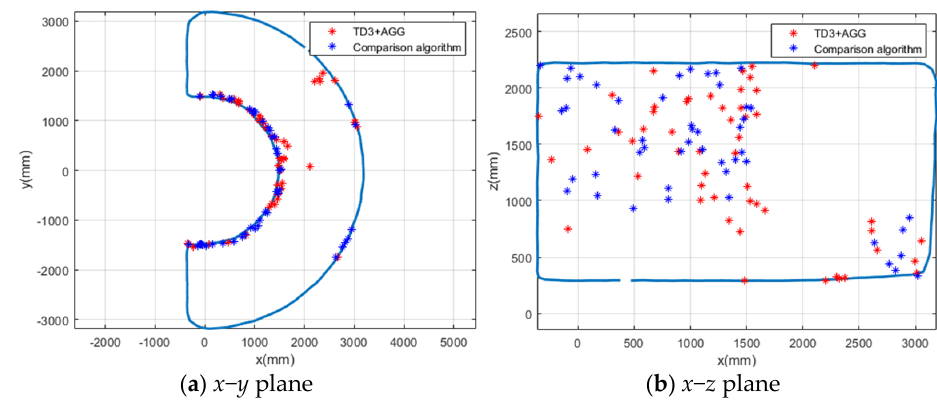
Figure 9. Positions of the targets that are not reached by the robot.